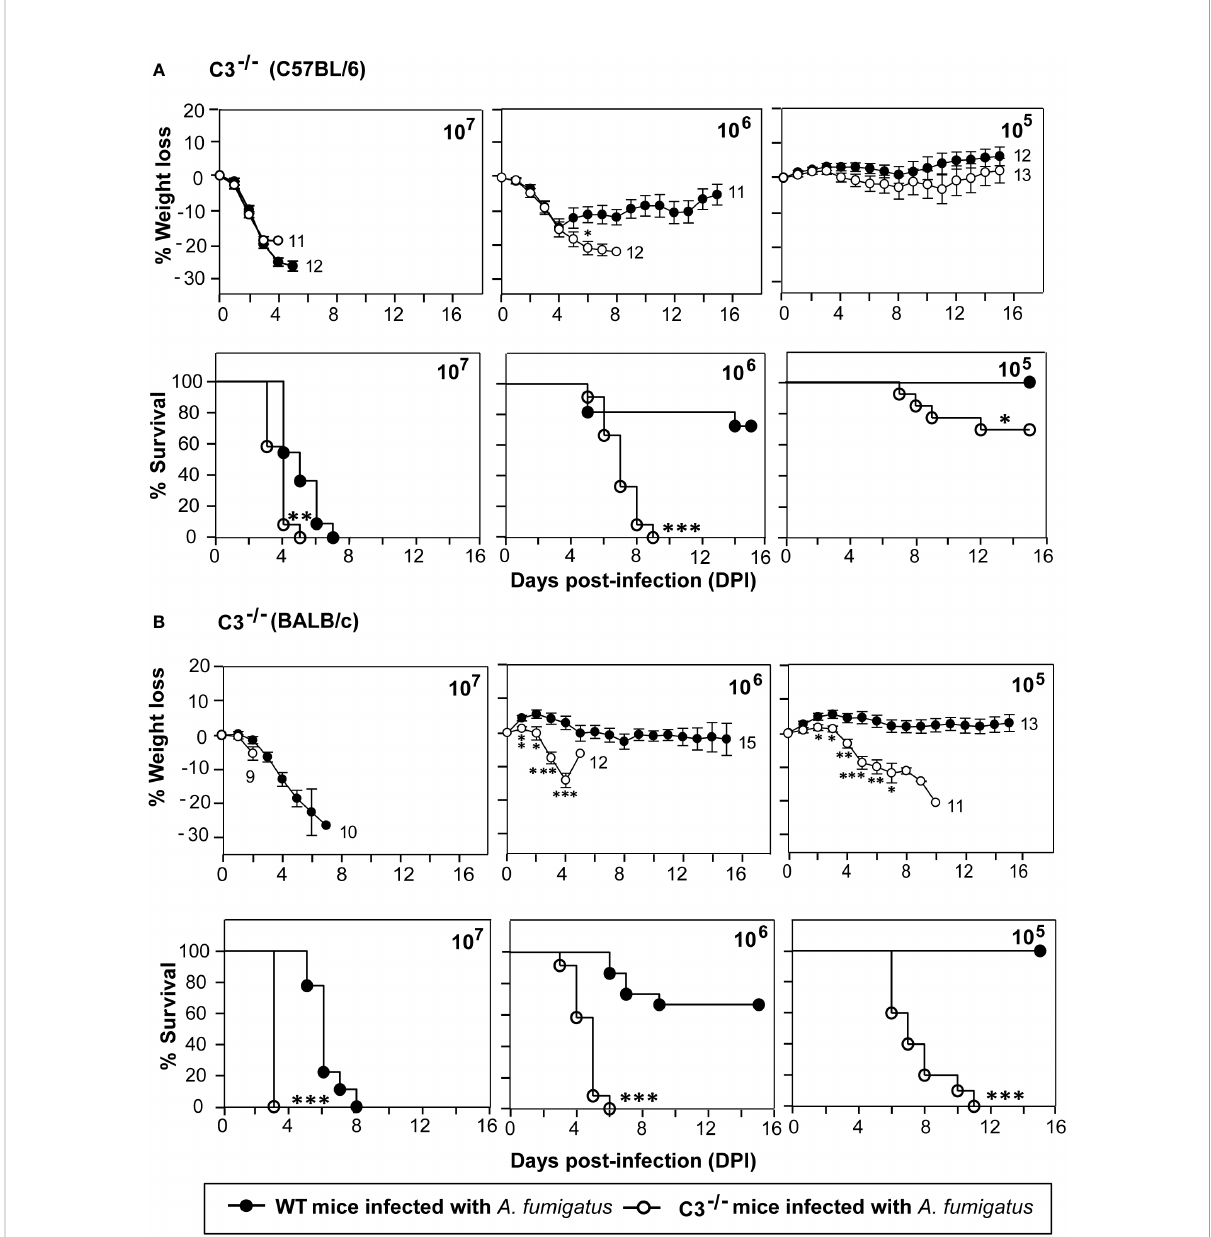
FIGURE 1 C3 de fi ciency enhances the susceptibility to systemic A fumigatus infection. Mice were intravenously infected with 1x10 5 , 1x10 6 , or 1x10 7 conidia suspended in PBS-T. The percent body weight change and survival of mice after the infection was recorded daily for 15 days. (A) Percentage of body weight loss and survival in complement C3 de fi cient mice (C3 -/- ; C57BL/6 background) in comparison to the wild-type mice (WT; C57BL/6 background). The body weights were normalized to their initial body weights. The numbers at the end of the line depict the number of mice used in that group. The survival in C3 -/- mice group was signi fi cantly lower in comparison with WT mice group at 1x10 5 and 1x10 6 dose of conidial infection (% weight loss: *p < 0.05; % survival: ***p < 0.0001, **p < 0.001, *p < 0.01). (B) Percentage of body weight loss and survival in complement C3 de fi cient mice (C3 -/- ; BALB/c background) in comparison to the wild-type mice (WT; BALB/c background). Similar to C57BL/6 C3 -/- mice, the BALB/c C3 -/- mice also showed reduced survival at 1 x 10 5 and 1 x 10 6 dose of conidial infection in comparison to the WT mice (% weight loss: *p < 0.05, **p < 0.005, ***p < 0.0005; % survival: ***p < 0.0001). Results shown are mean ± SEM of three independent